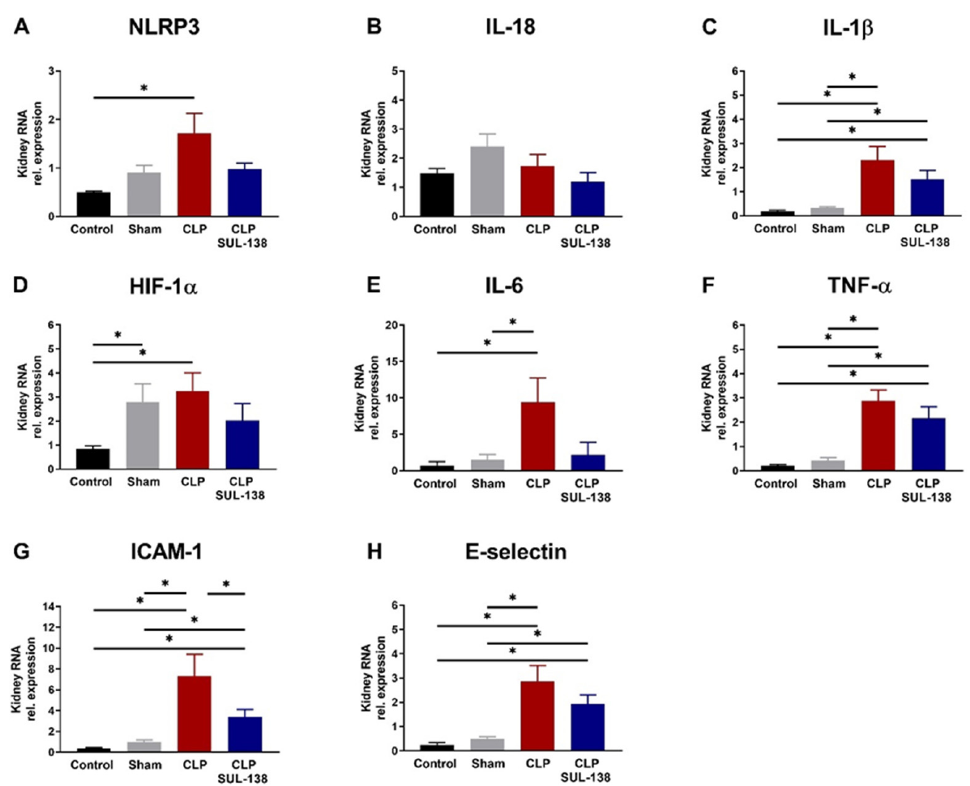
Figure 4. SUL-138 partly inhibited CLP-induced transcription of inflammatory markers in mouse kidney. Mice treated with SUL-138 (5 mg/kg) were injected s.c. 2 h before CLP induction, followed by a second dose at 10 h after CLP induction. Mice were euthanized 24 h after CLP induction and kidneys were collected. ( A ) CLP increased NLRP3 RNA expression levels, which was inhibited in the presence of SUL-138. ( B ) IL-18 RNA expression levels were similar in all groups. ( C ) CLP increased IL-1 β RNA expression levels, which was not inhibited in the presence of SUL-138. ( D ) CLP increased HIF-1 α RNA expression levels, but not in the presence of SUL-138. ( E ) CLP increased IL-6 RNA expression levels, which was inhibited in the presence of SUL-138. ( F ) CLP increased TNF- α expression levels, which was not inhibited in the presence of SUL-138. ( G ) CLP increased ICAM RNA expression levels, which was inhibited in the presence of SUL-138. ( H ) CLP increased E-selectin RNA expression levels, which was not inhibited in the presence of SUL-138. Control (n = 8), sham (n = 8), CLP (n = 8) and CLP SUL-138 (n = 6). Data are represented as mean ± SEM, * p < 0.05. CLP, cecal ligation and puncture.